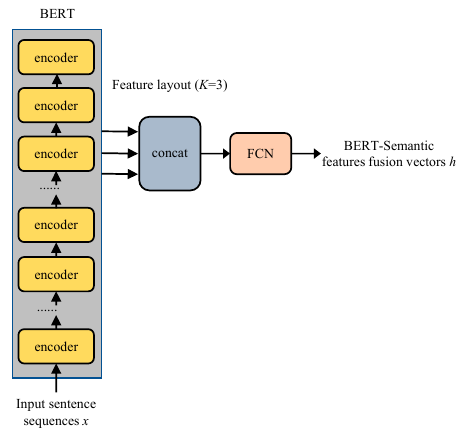
Figure 2. BERT-semantic fusion layer.